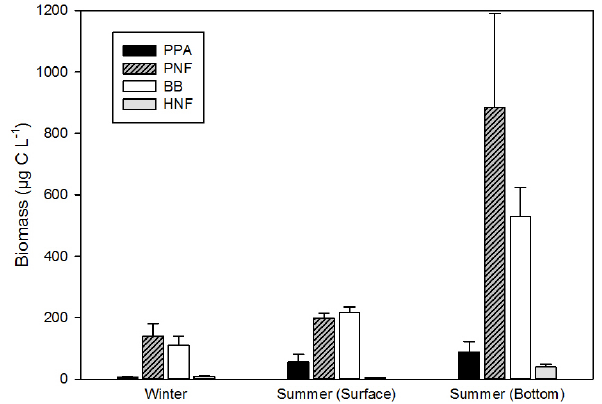
Figure 3. Seasonal changes in the biomass of phototrophic pi- coplankton (PPA), pigmented nanoflagellates (PNFs), bacteria (BB), and heterotrophic nanoflagellates (HNFs). Error bars repre- sent standard